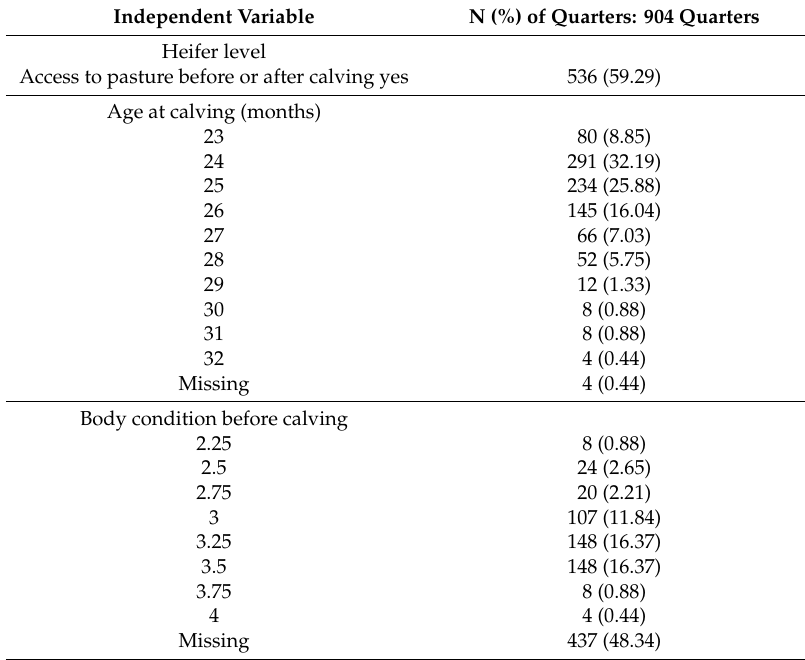
Table 2. Number and proportion of heifers and quarters for the risk factors included in the